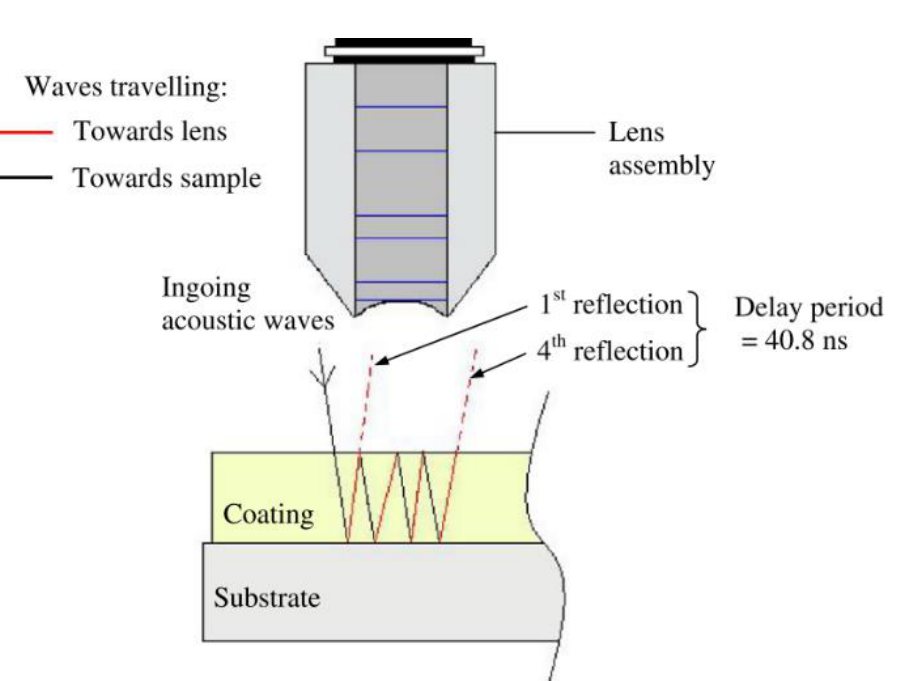
Figure 5. The use of acoustic waves to measure coating thickness. (Reprinted with permission from ref. [34]. Copyright 2008 Elsevier).